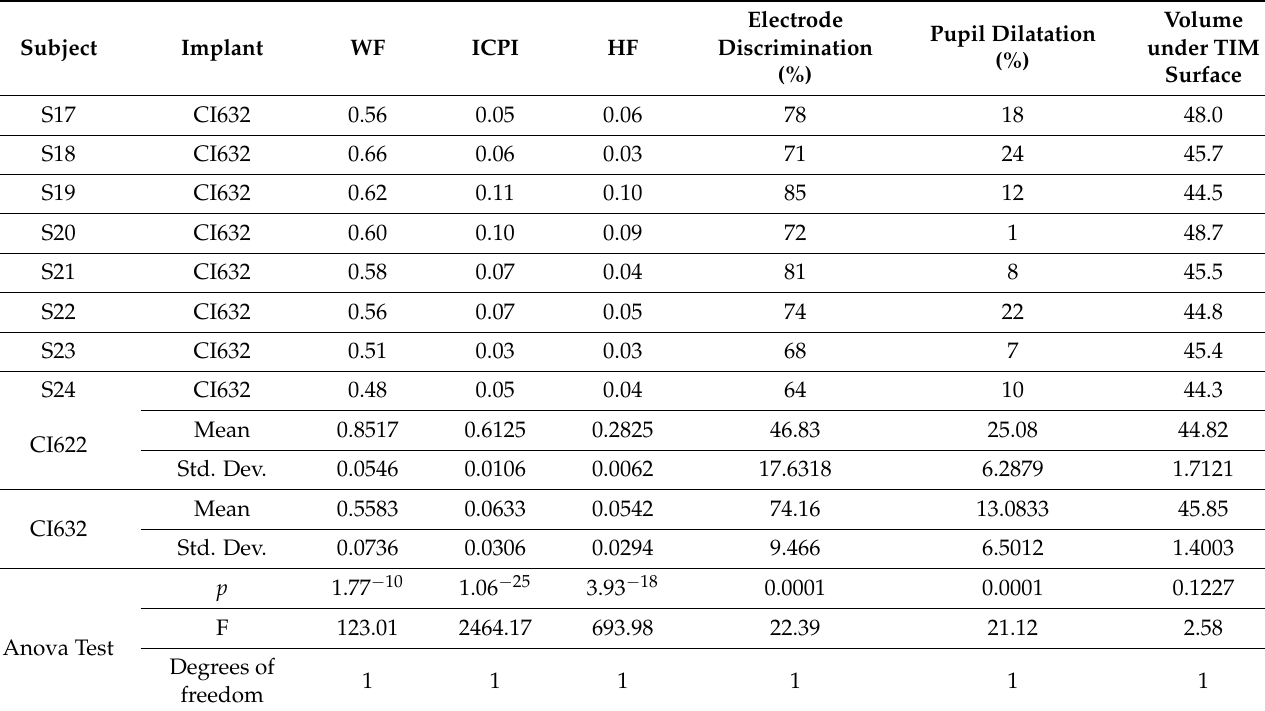
Figure 3. Pupil dilatation result comparison chart between CI632 and CI622 recipients during electrode discrimination test (* p < 0.05).